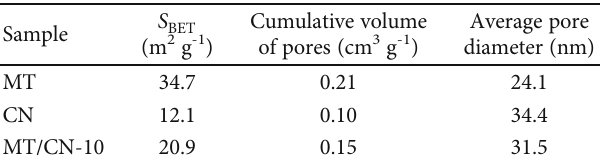
Figure 4: The N adsorption-desorption isotherms and pore size 2 distributions (inset of the fi gure). Table 1: Physicochemical properties of MT, CN, and MT/CN-10